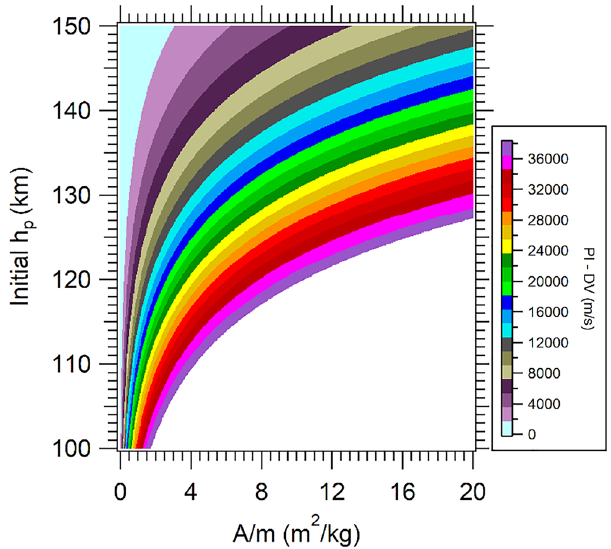
Figure 7. PI maps for VP = 1.89 VU.